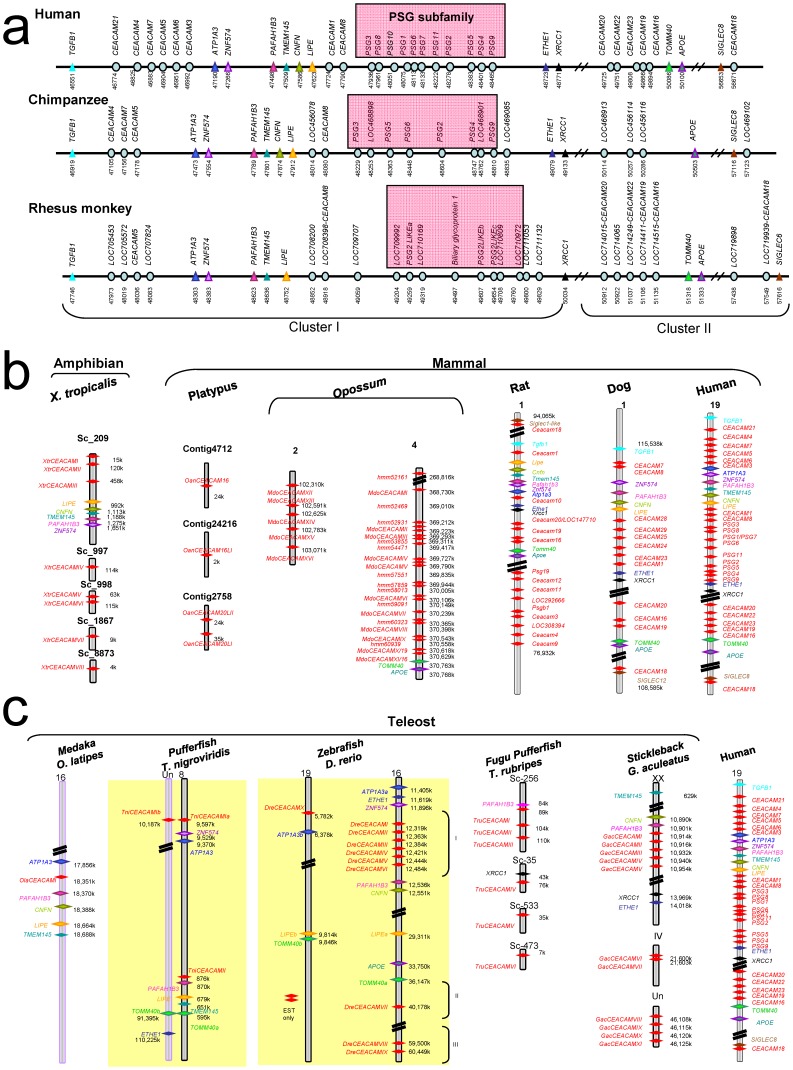
Syntenic mapping of CEACAM/PSG family genes in vertebrates.
a) Syntenic mapping of the CEACAM/PSG locus in human, chimpanzee (P. troglodytes), and Rhesus monkey (M. mulatta). CEACAM/PSG genes of these primates can be subdivided into two clusters: cluster I genes are flanked by orthologs of TGFB1 and XRCC1 whereas cluster II genes are close to orthologs of TOMM40, APOE, and SIGLEC8. All CEACAM subfamily genes are indicated by blue oval symbols. CEACAM/PSG locus marker genes, including TGFB1, ATP1A3, ZNF574, PAFAH1B3, TMEM145, CNFN, LIPE, ETHE1, XRCC1, TOMM40, APOE, and SIGLEC8, are indicated by triangle symbols. The PSG subfamily genes are indicated by shaded square boxes. The relative position of genes is shown under gene symbols in Kbp. b) Syntenic mapping of CEACAM family genes in dog, rat, the gray short-tailed opossum (M. domestica), platypus (O. anatinus), and the clawed frog (X. tropicalis). The opossum contains more than three dozen paralogs on multiple chromosomes (Table S2 in File S1). For the opossum, only paralogs mapped on chromosomes 2 and 4 are shown. Those found on unknown chromosomes are described in Table S2 in File S1. Among these homologs, eleven (MdoCEACAMI-XI) were found to cluster in a 2-Mbp span on chromosome 4, which also contained the marker genes TOMM40 and APOE. On the other hand, the platypus genome encoded four CEACAM homologs (OanCEACAM16, 16LI, 20LI, and 20LII)(Table S2 in File S1). In X. tropicalis, three homologs (XtrCEACAMI-III) were located near marker genes, including LIPE, CNFN, TMEM145, PAFAH1B3, and ZNF574. The chromosomal number and the genomic contig number are indicated at the top of the schematic representation of each genomic fragment. CEACAM family genes are indicated by red diamond-shaped symbols. Marker genes are identified by colored diamond-shaped symbols. The relative position of genes on chromosomes and contigs is shown next to the gene symbols. c) Syntenic mapping of CEACAM loci in teleosts. The genomes of the medaka fish (O. latipes), stickleback (G. aculeatus), zebrafish (D. rerio), and two pufferfishes (T. rubripes and T. nigroviridis) encode 1–12 CEACAM family genes. Syntenic mapping indicated that zebrafish and T. nigroviridis CEACAM genes are located on whole genome duplication (WGD)-derived chromosome fragments, and that zebrafish CEACAMs on chromosome 16 are located on three separate loci (I, II, and III). The WGD-derived syntenic chromosomal regions in teleosts are indicated by a yellow background. The chromosomal number and the genomic contig number are indicated at the top of the schematic representation of each genomic fragment. CEACAM family genes are indicated by red diamond-shaped symbols. Marker genes are identified by colored diamond-shaped symbols. The relative position of genes on chromosomes and contigs is shown next to the gene symbols.